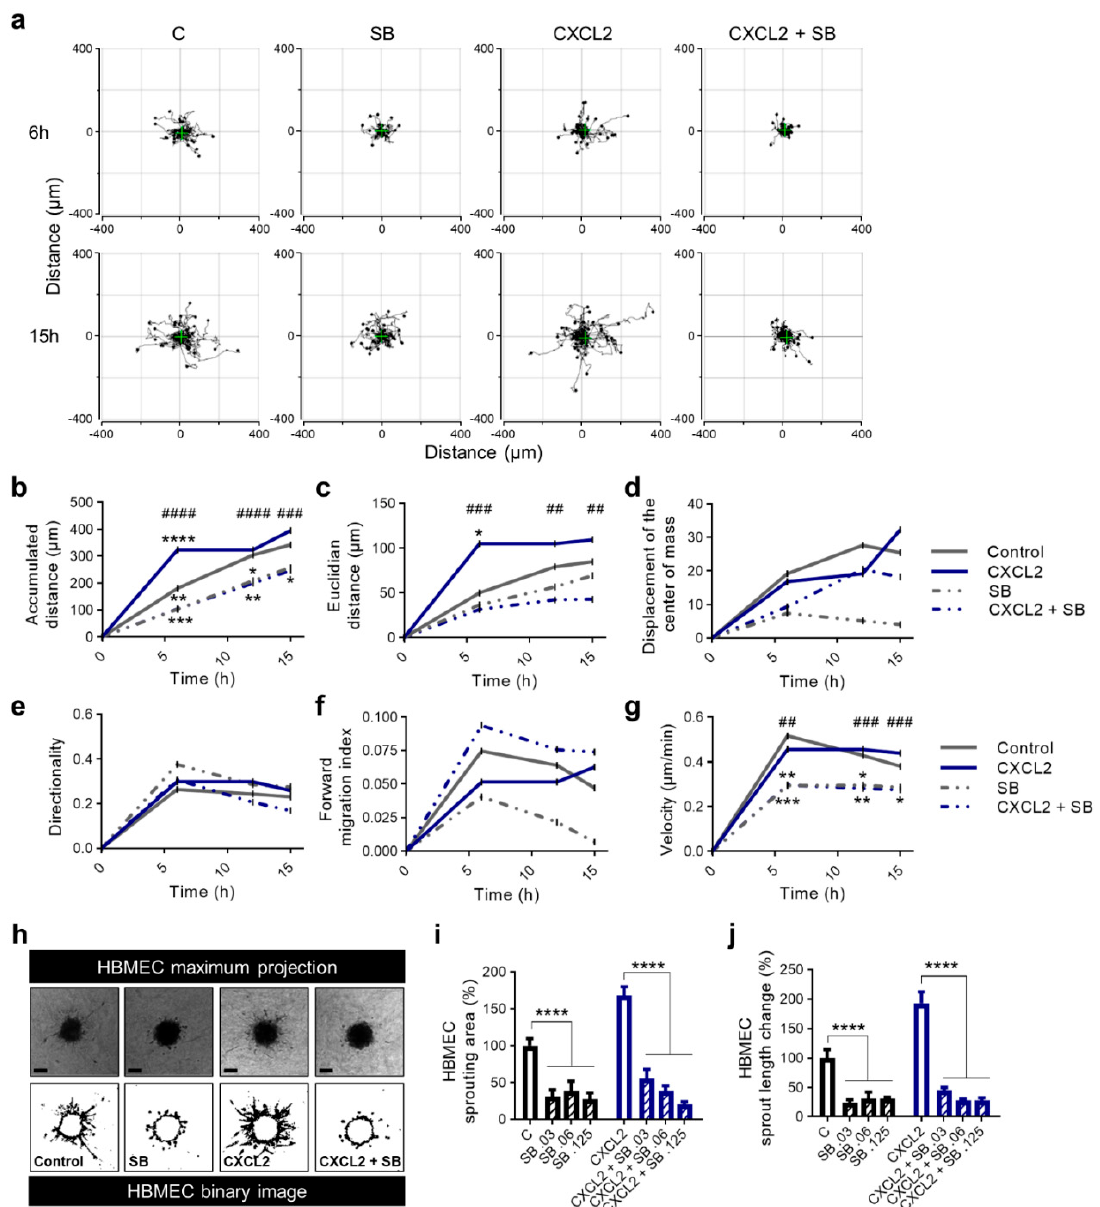
Figure 6. SB225002 reduces chemokinesis and sprouting ability of primary human endothelial cells. ( a – g ) HUVEC were seeded into µ -slides. CXCL2 (10 ng/mL), SB225002 (SB), a combination of CXCL2 + SB225002 and 0.1% FCS in ECBM2 medium as control were added to create a chemokine gradient. The cells were imaged over 15 h by time-lapse microscopy and analyzed after 6, 12 and 15 h. Representative trajectory plots after 6 and 15 h are depicted. The green cross represents the center of mass ( a ). Quantitative data of accumulated distance ( b ), Euclidian distance ( c ), displacement of the center of mass ( d ), directionality ( e ), forward migration index ( f ) and velocity ( g ) are shown. Rayleigh test p values were not significant for any condition indicating that the distribution of the cell end points was homogenous. Graphs show the mean values of all surviving tracked cells of one representative experiment. * indicating the level of significance compared to the control group; # indicating the level of significance comparing CXCL2 with CXCL2 + SB ( b – g ). ( h – j ) 3D Sprouting assay of HUVEC spheroids was performed in response to the treatment with CXCL2 (25 ng/mL) and SB225002 (0.03 µ M, 0.06 µ M, 0.125 µ M) and in combination as indicated. Representative images show the maximal projection and the binary image of spheroids. Scale bars 100 µm ( h ). Sprouting area ( i ) and mean sprout length change ( j ) were calculated. Graphs represent multiple experiments with similar results ( n = 3-4 spheroids/condition). * p < 0.05, ** p < 0.01, *** p < 0.001, **** p < 0.0001; ## p < 0.01, ### p < 0.001, #### p < 0.0001; one-way ANOVA (Bonferroni correction).